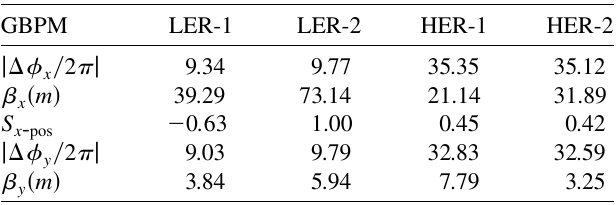
TABLE II. Optical parameters of each monitor, the phase advance from the IP and the betatron function at the monitors without the dynamic beam-beam effects. The position sensitiv- for measuring the horizontal position shift is a relative ity, S x - pos value, when we set that of LER-2 to be 1.0 as a reference.